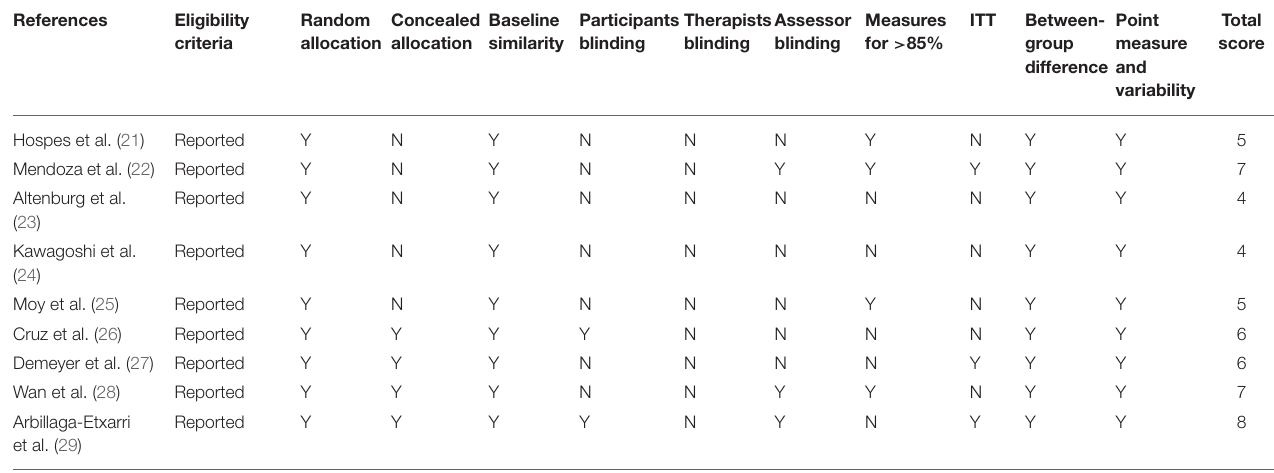
TABLE 2 | Quality assessment